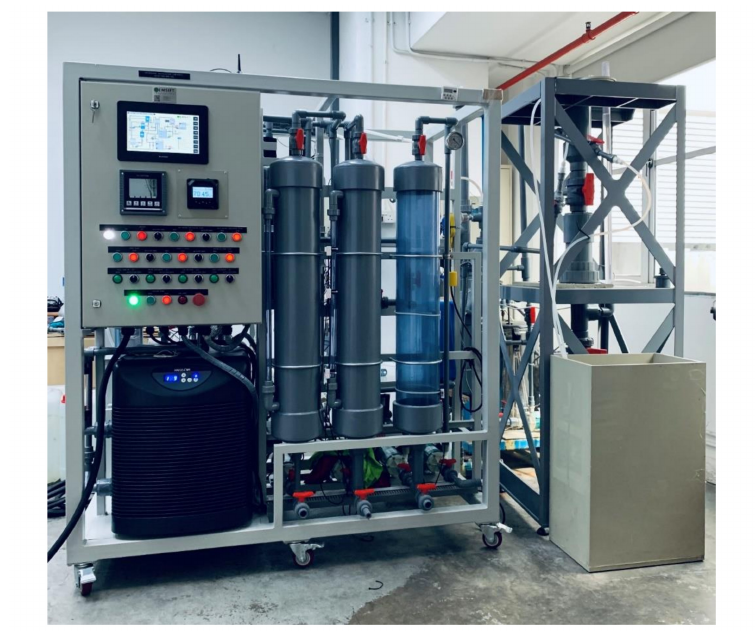
Figure 1. ( a ) Process flow diagram, ( b ) schematic around the membrane module and ( c ) actual image of the zero liquid discharge